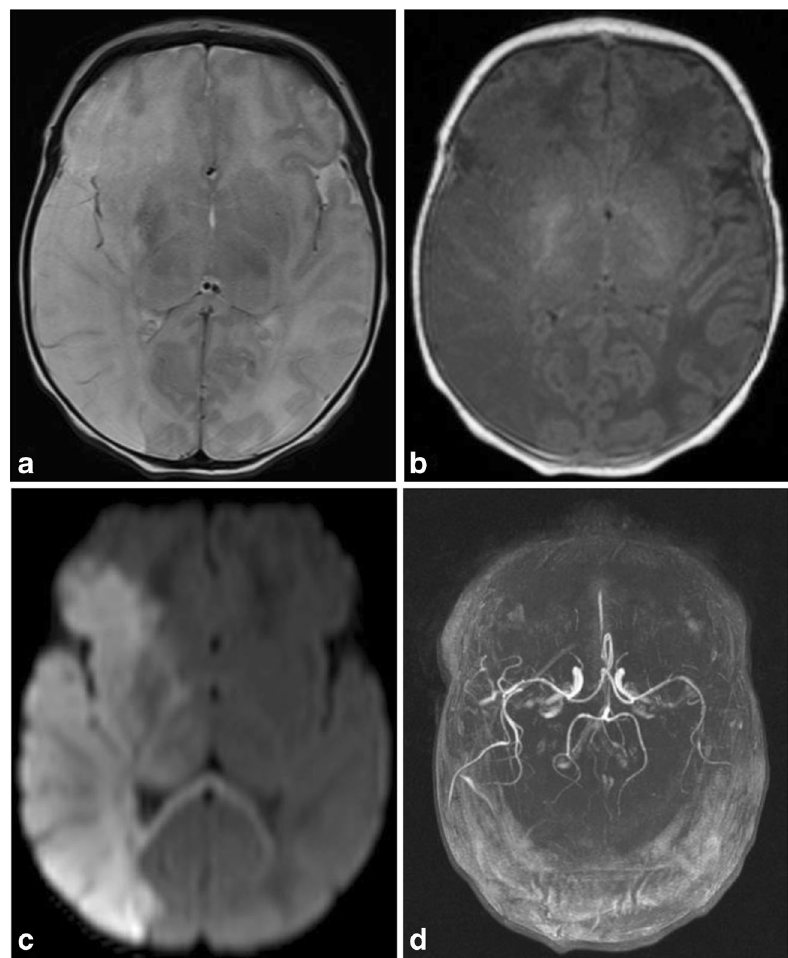
Fig. 11 Middle cerebral artery infarct in a 4-day-old male with historyofprolonged deliverywith nuchal cord presenting with seizures Axial T2 (a), T1(b) and diffusion MR (c) images demonstrate an extensive region of hypointense T1 and hyperintense T2 signal involving right cerebral hemisphere in the distribution of the middle cerebral artery, with effacement of the sulci and right lateral ventricle, with corresponding restricted diffusion, consistent with right MCA distribution subacute ischemic infarct. Restricted diffusion also extends into the right thalamus, basal ganglia, cerebral peduncle and across the splenium of the corpus callosum. Axial MIP image (d) from a 2 D time-of-flight MR angiogram of the head without contrast shows normal intracranial arteries with no evidence of decreased or absent flow in the right MCA